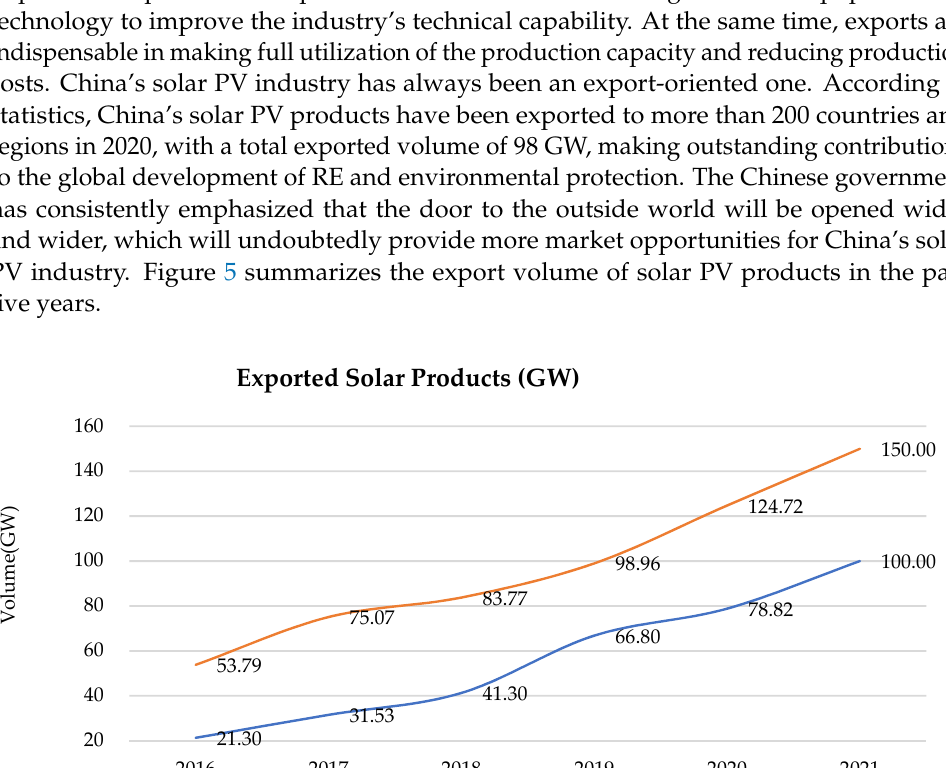
Figure 4. China’s energy mix by 2019 and estimated energy mix by 2030. Source: National Bureau of Statistics of China https://data.stats.gov.cn/english/easyquery.htm?cn=C01 (accessed on 20 April 2021).